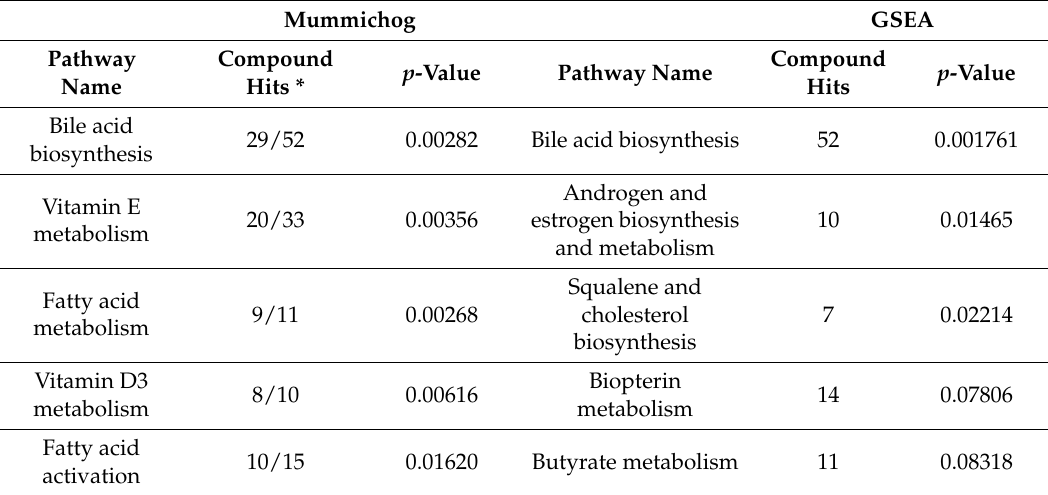
Figure 3. The scatter plot integrating GSEA (x-axis) and mummichog (y-axis) pathway analysis results. The size and color of the circles correspond to their transformed combined p -values. The blue and pink areas highlight significant pathways based on either GSEA (pink) or mummichog (blue). Table 2. The top five enriched metabolic pathways identified using the mummichog algorithm ( PerformMummichog ) and GSEA ( PerformGSEA ) in MetaboAnalystR 2.0.